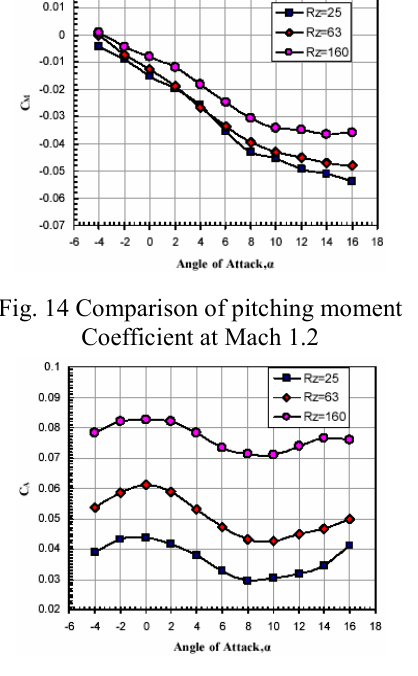
Fig. 16 Comparison of axial force Coefficient at Mach 1.2